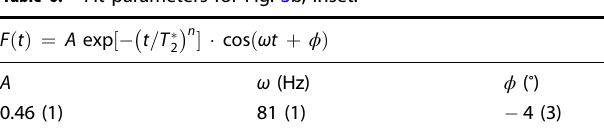
Table 6. Fit parameters for Fig. 3b, inset.